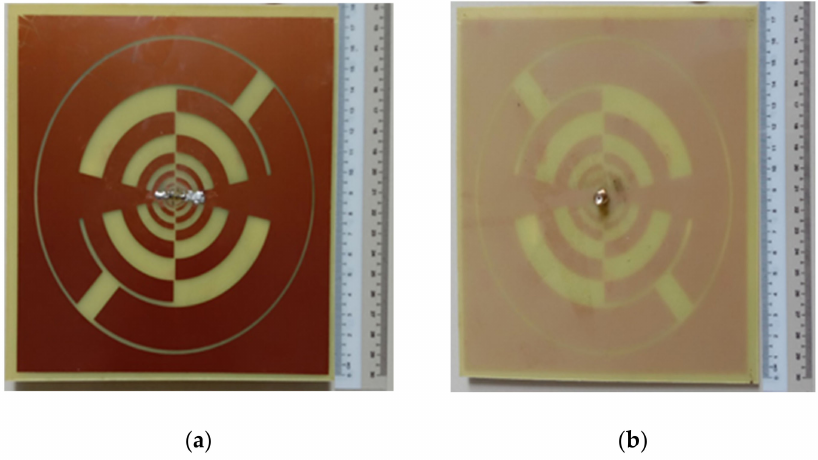
Figure 6. Fabricated prototype ( a ) front side ( b ) backside of the proposed antenna.